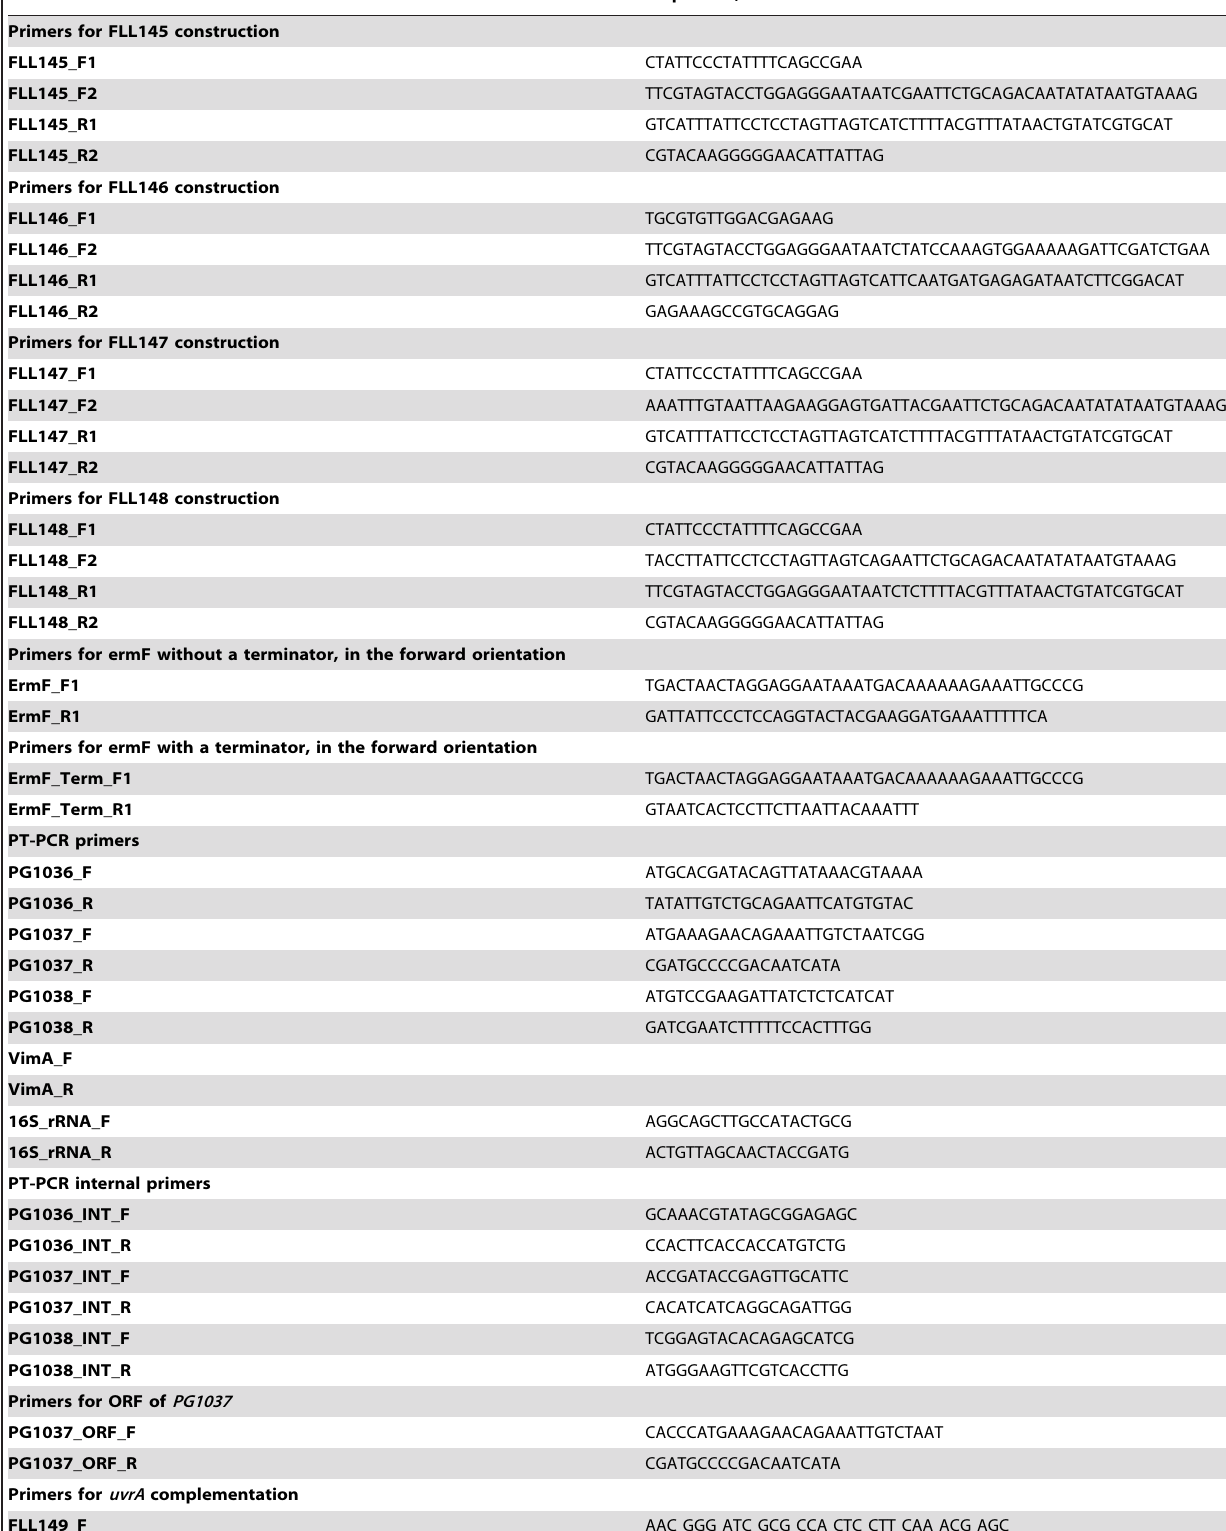
Table 2. Primers used in this